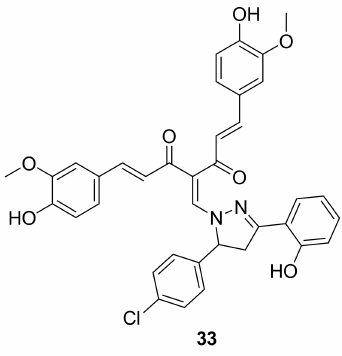
Figure 36. Structure of compound 33 , an IKK kinase inhibitor. Molecular docking of compound 33 and other derivatives was performed with the crystal structure of IKK β in the hinge region as the ATP binding site for favorable inter- actions (Figure 37). The co-crystallized inhibitor KSA was employed as the control ligand. Curcumin interacts with the gatekeeper residue Glu97, forms a hydrogen bond with Asp166, and has several hydrophobic interactions with the activation loop. Most of the designed com- pounds interacted with Glu97 and Cys99 residues, which was ATP’s adenine target during ATP’s interaction with the catalytic domain of IKK β . Compound 33 interacts with Glu97 and Cys99 of the binding pocket of the receptor through the hydroxyl oxygen of curcumin’s back- bone, while hydroxyl’s oxygen at pyrazole accepts hydrogen bonds from Gly24 and Thr23. Carbonyl oxygen of curcumin forms a hydrogen bond interaction with Asn150 [48].